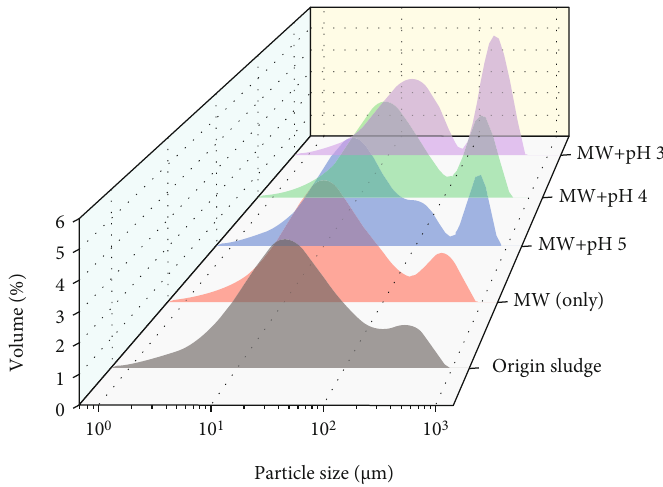
Figure 5: The particle size distribution curves of sludge with di ff erent pHs treated by microwave at 700 W for 180s.